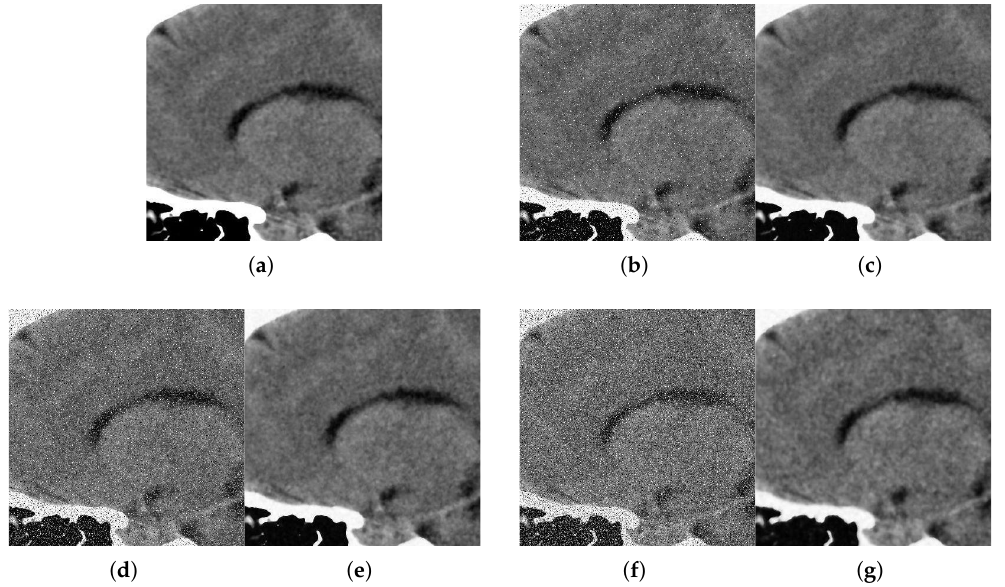
Figure 12. Method outputs. Sagittal view corrupted with impulsive noise p and Gaussian σ . ( a ) Original sagittal. ( b ) Noisy p = 0.1, σ = 10. ( c ) Method output. ( d ) Noisy p = 0.2, σ = 20. ( e ) Method output. ( f ) Noisy p = 0.3, σ = 30. ( g ) Method